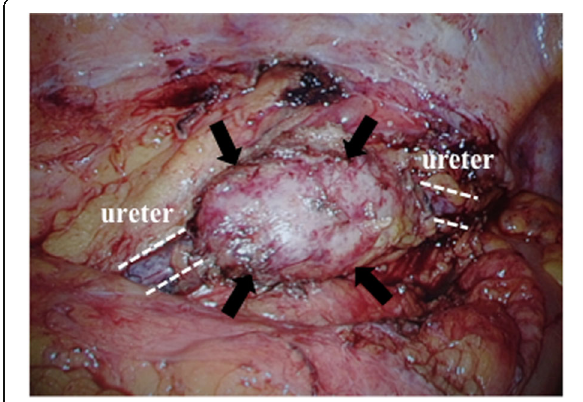
Fig. 3 Intraoperative findings. The mass around the left ureter was observed (mass; black arrow, ureter; white dotted